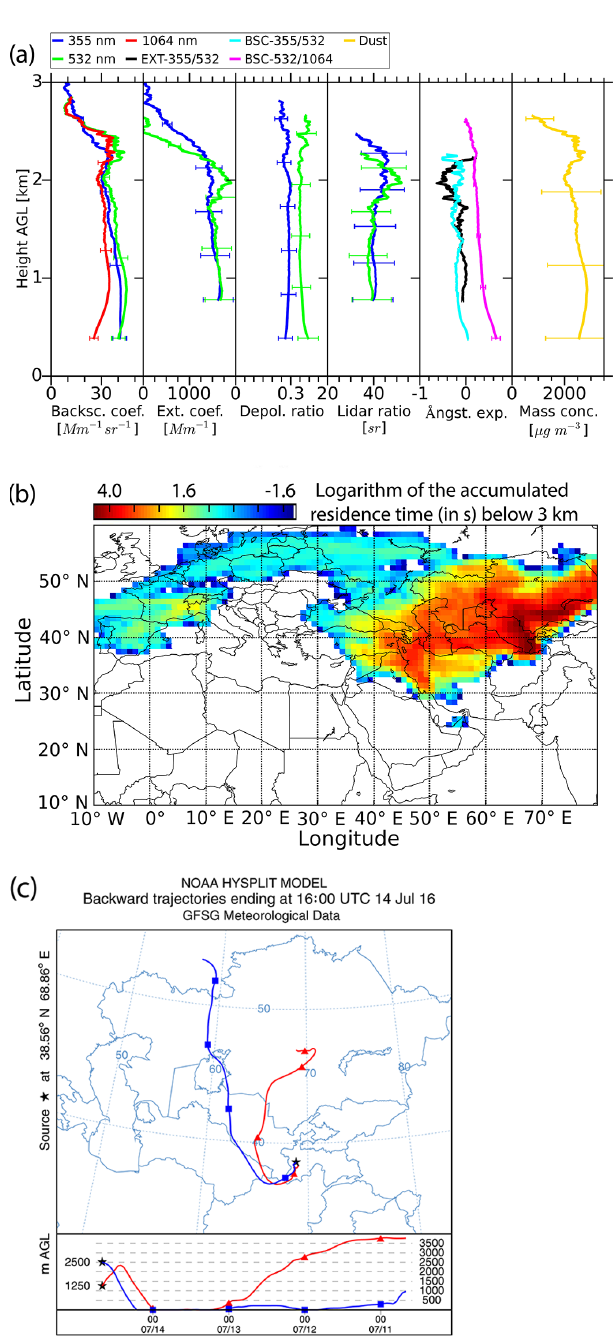
Figure 7. Case 3: the most extreme dust event with an AOT of above 4 (at 500nm wavelength) and a calculated dust mass con- centration of 2.8mgm − 3 is shown. The dust source regions are in Central Asia. (a) Same as Fig. 5b. The averaged lidar profiles were measured on 14 July 2016, 16:00–22:00UTC. Lidar signals are smoothed before calculation of the extinction-related (743m) and backscatter-related (248m) optical properties. (b) 120h FLEX- PART backward trajectories same as in Fig. 4d, e, f, but arriving on 14 July 2016, 20:30–21:30UTC between 0.5 and 2.6km height. (c) 96h HYSPLIT backward trajectories arriving at Dushanbe at 16:00UTC at 1.25, and 2.5km